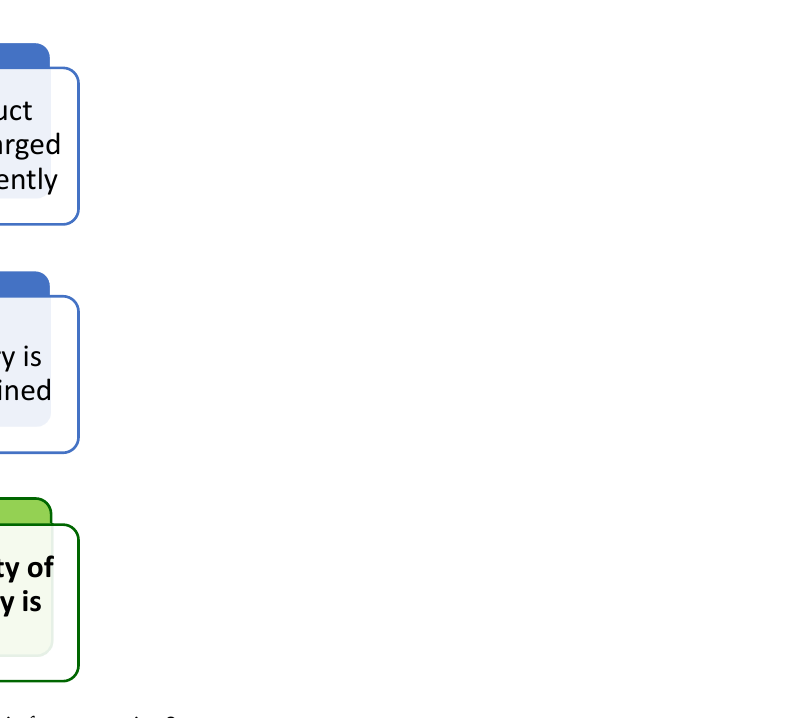
Table 7. System parameters for technical contradictions (constraint 2).